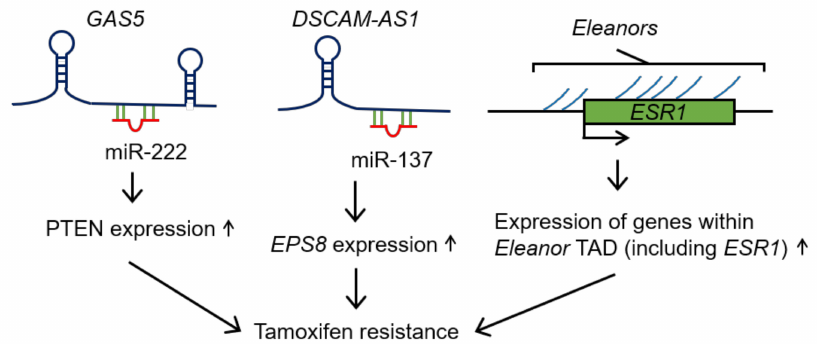
Figure 4. Schematic representation of the functions of GAS5 , DSCAM-AS1 , and Eleanors in the tamoxifen resistance of breast cancer. GAS5 sponges miR-222 and upregulates PTEN expression to enhance tamoxifen resistance. DSCAM-AS1 also sponges miR-137 to increase EPS8 , which contributes to tamoxifen resistance. On the other hand, Eleanors promotes tamoxifen resistance by upregulating ESR1 expression. GAS5 : growth-arrest specific 5 ; DSCAM-AS1 : Down syndrome cell adhesion molecule antisense RNA 1 ; Eleanors : ESR1 locus enhancing and activating noncoding RNAs; PTEN: phosphatase and tensin homolog; EPS8 : epidermal growth factor receptor pathway substrate 8